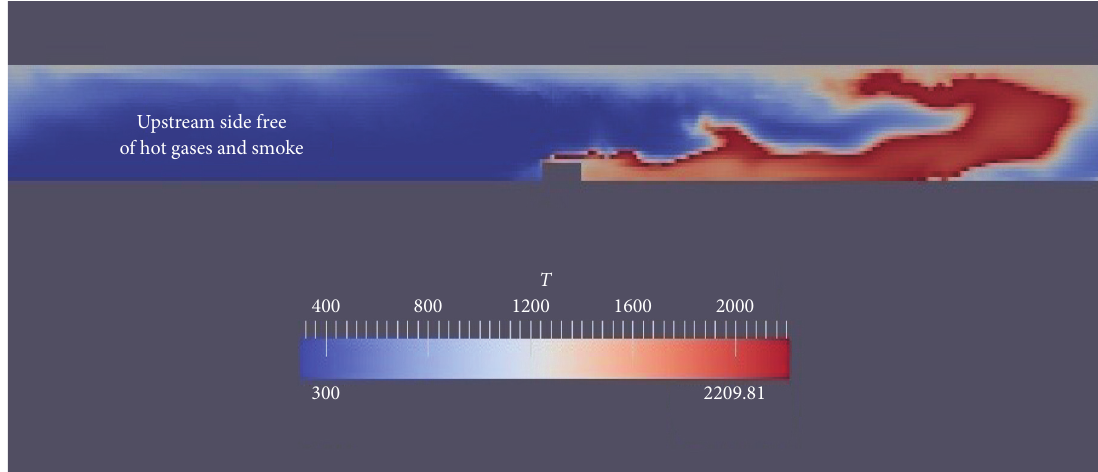
Figure 12: Visualization of upstream free of fire products at 𝑉 𝑖 = 0.38